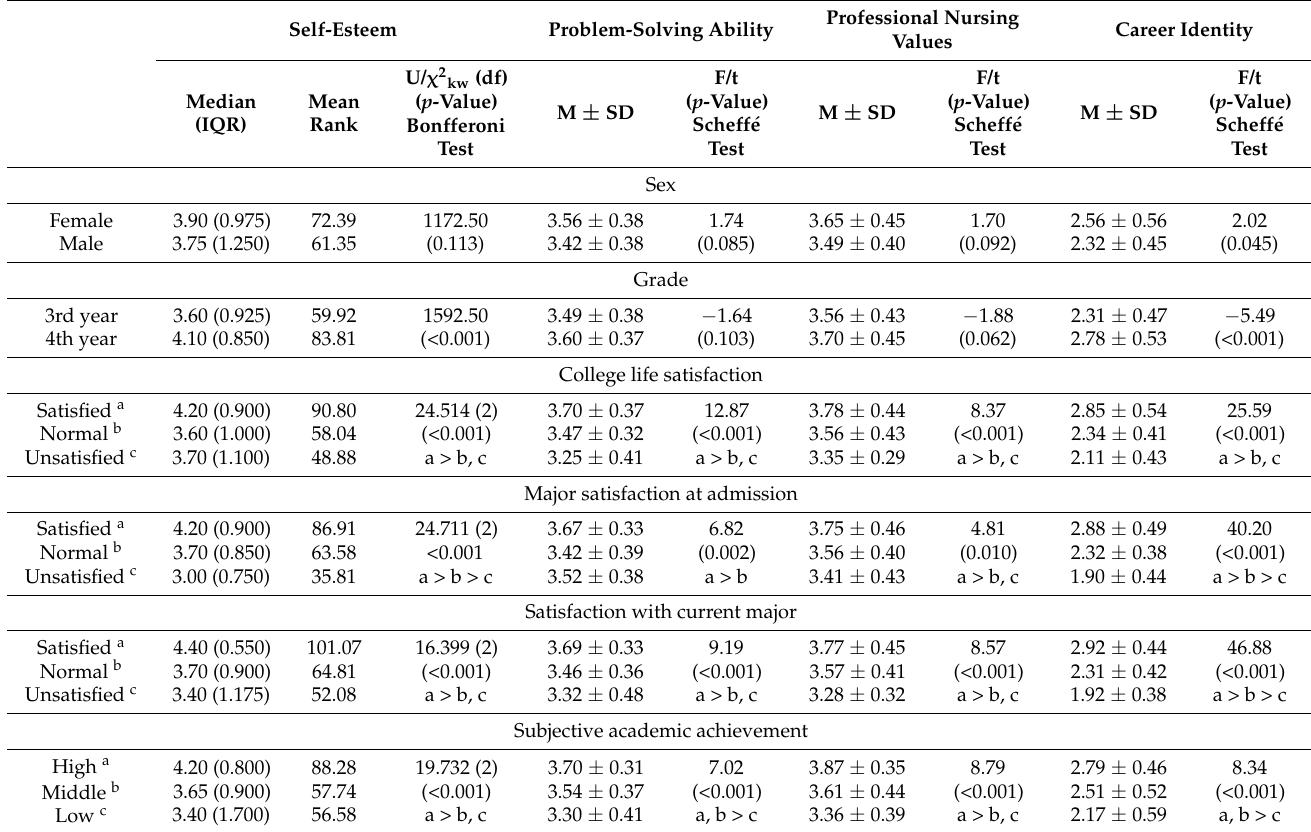
Table 3. Differences in variables according to the participants’ general characteristics ( N =